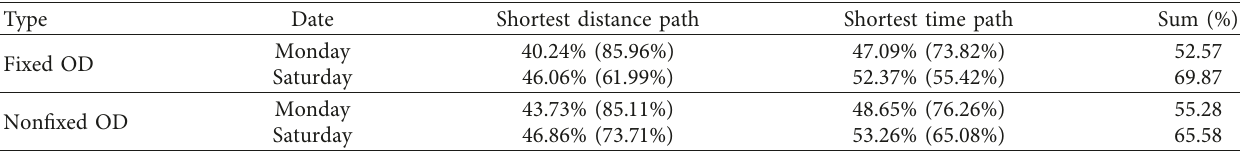
Table 10: The proportion of shortest path selection for fixed and nonfixed OD trips.